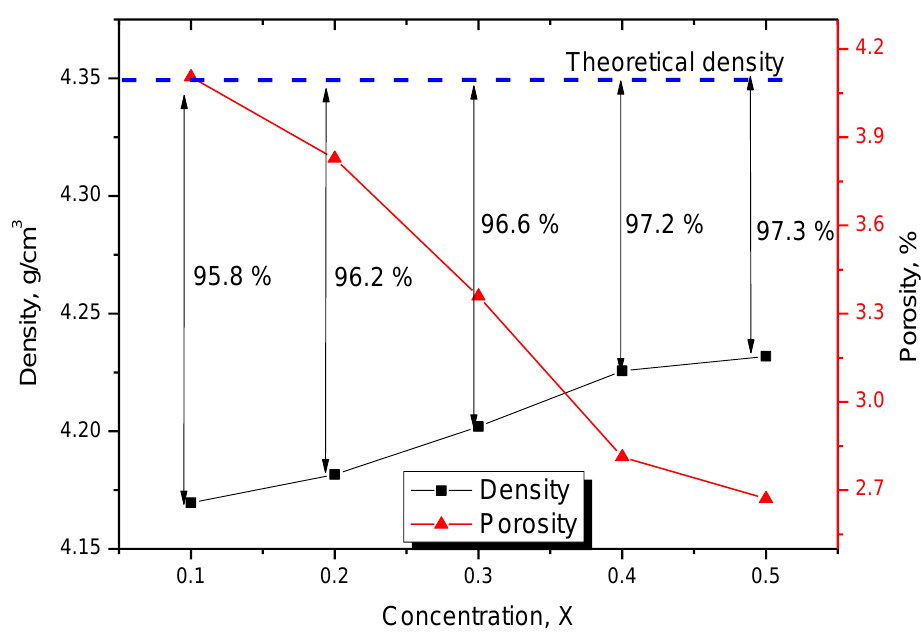
Figure 4. Ceramic density and porosity change results.